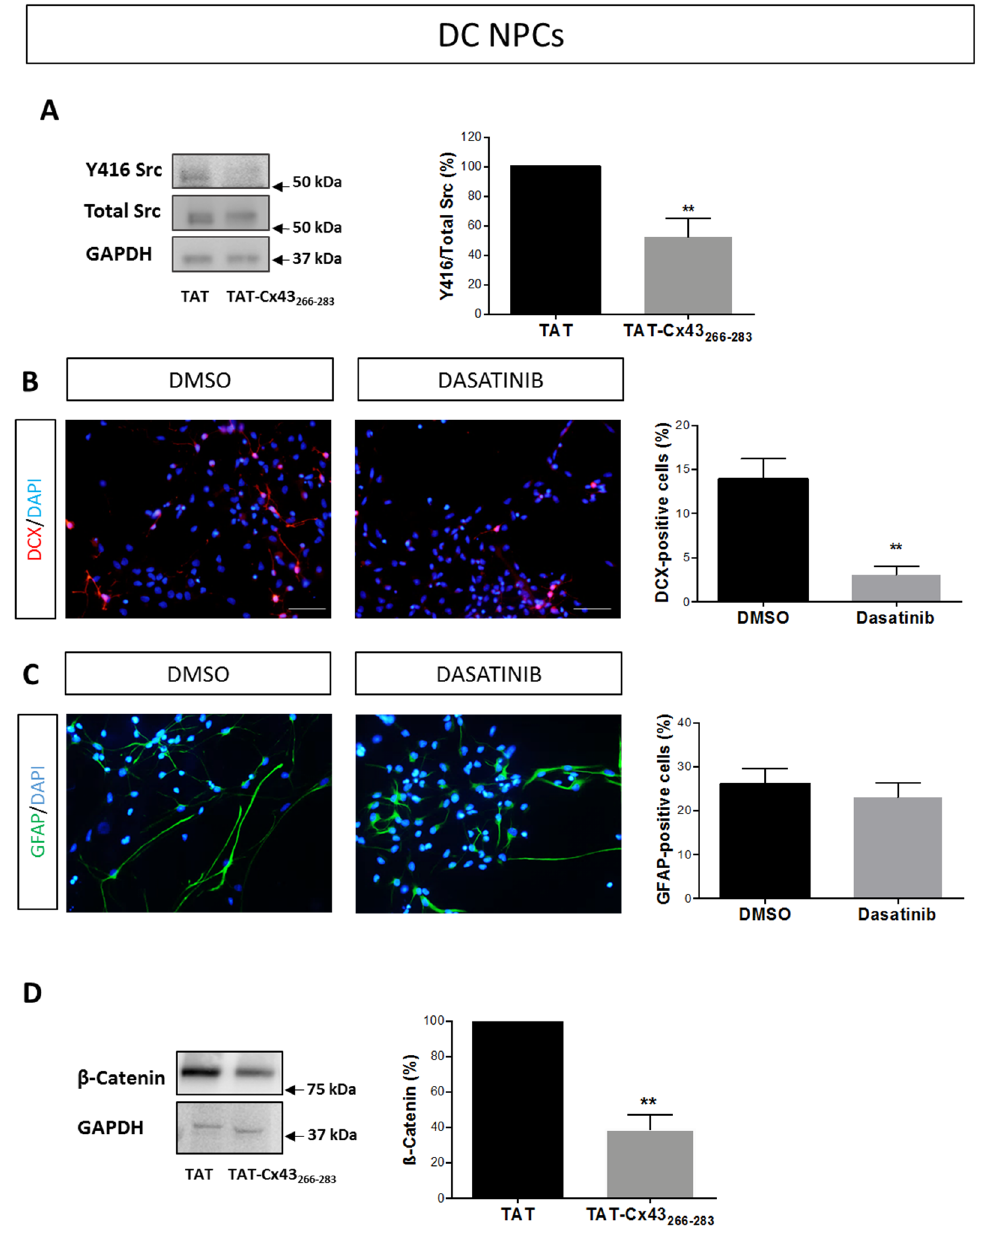
Figure 6. Involvement of Src and β -catenin in the e ff ects of TAT-Cx43 266–283 on neural progenitor cell di ff erentiation. ( A ) Western blots showing Y416 Src and total Src in neural progenitor cells treated with 25 µ M of TAT or TAT-Cx43 266–283 in di ff erentiation conditions for 96 h. Quantification of Y416 Src / Src ratio expressed as a percentage of TAT. Results are the mean ± SEM ( n = 5; ** p < 0.01; Student’s t -test). ( B ) Representative images showing doublecortin (DCX) immunoreactivity (red) in neural progenitor cells in di ff erentiation conditions (DC NPCs) after 96 h of treatment with DMSO or with 1 µ M Dasatinib. Cell nuclei were labeled with DAPI (blue). Bar: 50 µ m. Percentage of DCX-positive cells in both experimental conditions. Results are shown as mean ± SEM ( n = 5; ** p < 0.01; Student’s t -test). ( C ) Representative images showing glial fibrillary acidic protein (GFAP) immunoreactivity (green) in DC NPCs after 96 h of treatment with DMSO or with 1 µ M Dasatinib. Cell nuclei are labeled with DAPI (blue). Bar: 50 µ m. Percentage of GFAP-positive cells in both experimental conditions. Results are shown as mean ± SEM ( n = 6; non-significant di ff erences; Student’s t -test). ( D ) β -catenin levels were analyzed by western blotting in DC NPCs treated with 25 µ M of TAT or TAT-Cx43 266–283 for 96 h. The bar graph shows the ratio of β -catenin / GAPDH in percentage with respect to TAT (mean ± SEM; n = 3; ** p < 0.01; Student’s t